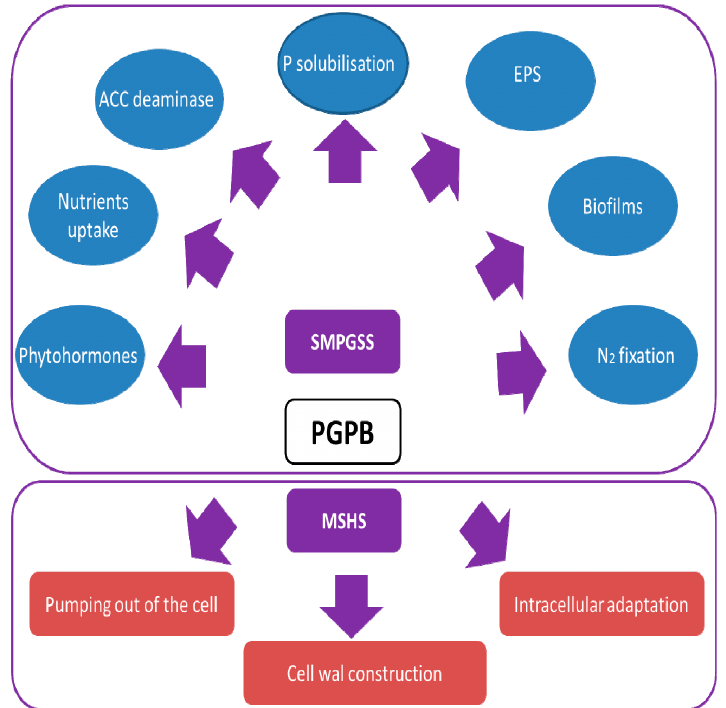
Figure 2. PGPB (Plant growth promoting bacteria) salinity resistance strategies and mechanisms of plant growth improvement under salt stress (SMPGSS: stimulation mechanisms of plant growth under salt stress; MSHS: mechanisms surviving high salinity, PGPB: plant growth-promoting bacteria, EPS: exopolysaccharides).